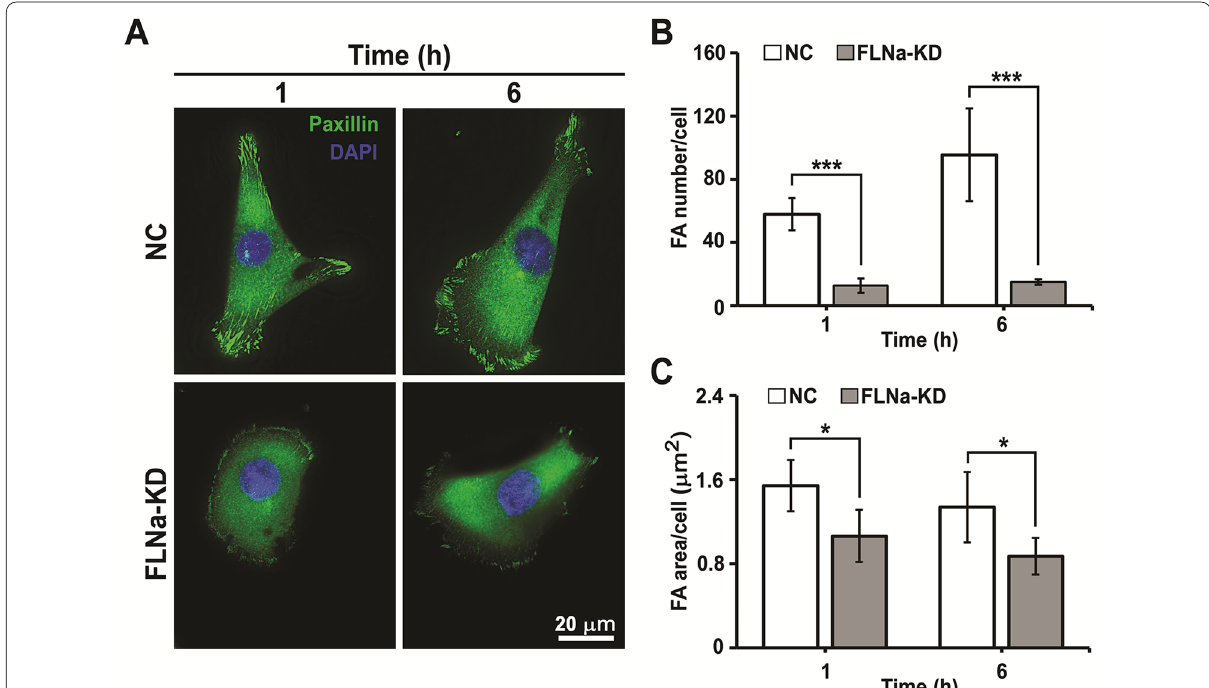
Fig. 4 FA number and size of NC and FLNa-KD cells on glass slides coated with fibronectin at 1 and 6 h. A Immunostaining of paxillin (PXN, green) in cells. FA number ( B ) and size ( C ). Error bar represents the mean